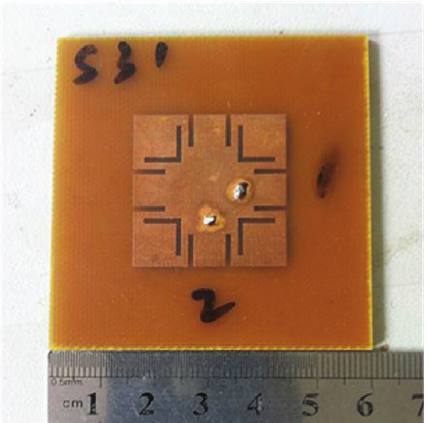
Figure 4: Fabricated proposed antenna.